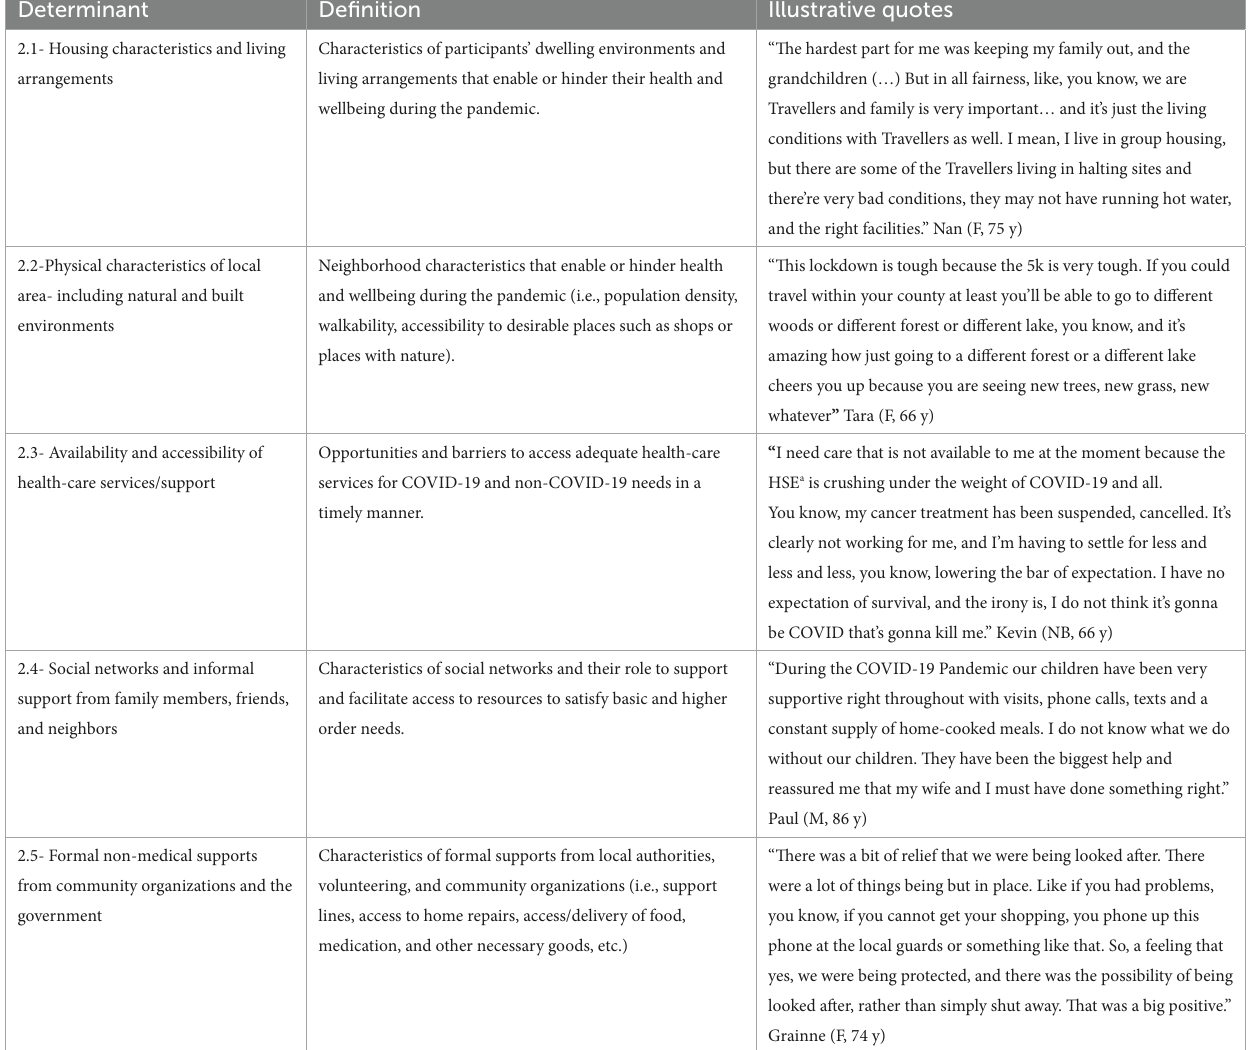
TABLE 3 Detailed socio-ecological determinants at the micro-system